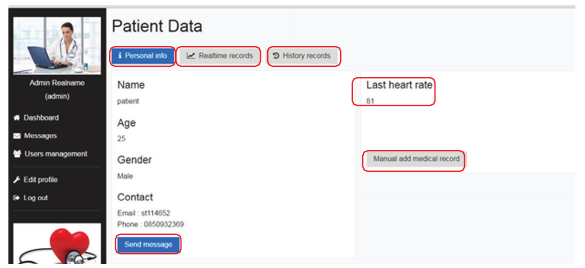
Figure 4: Patient data interface in web application.